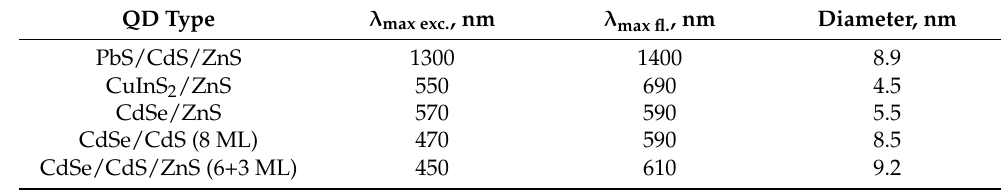
Table 1. Composition and optical properties of the synthesized water-insoluble quantum dots.